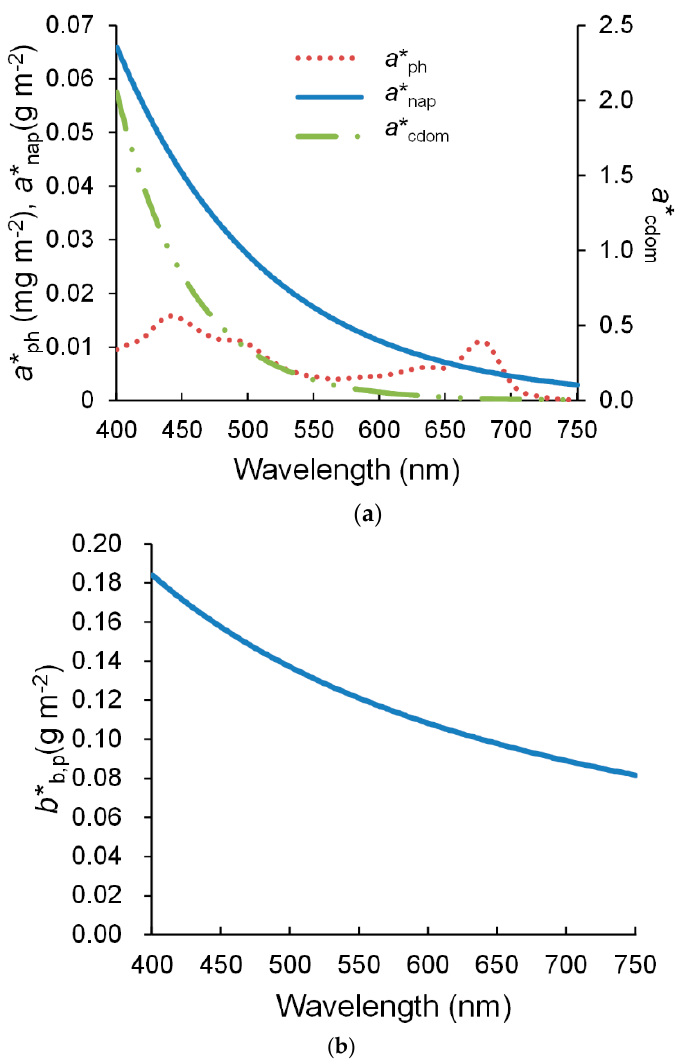
Figure 7. Specific inherent optical properties for the Wabash River and the Tippecanoe River: ( a ) absorptions; and ( b ) backscattering.